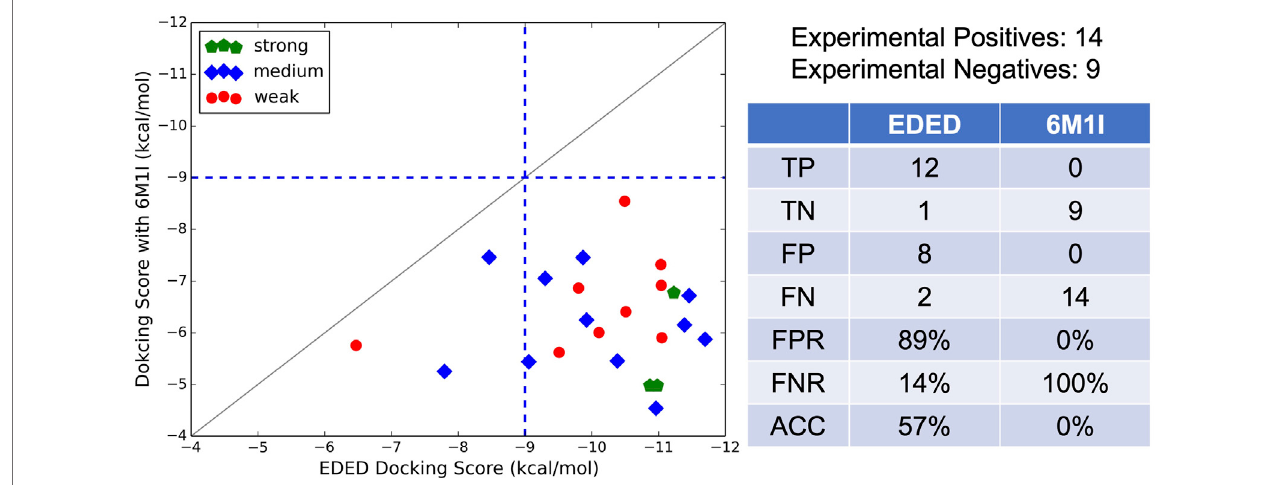
FIGURE 4 | Ensemble weighted glide scores ( Δ G bind ) of 23 experimentally tested compounds. Compounds with strong, modest, and poor ERK inhibitive activity are depicted in green, blue, and red, respectively. Corresponding colored lines represent the average ensemble weighted glide score for that category. A cutoff of – 9 kcal/mol was applied for predicted antagonists to be compared to their experimental results showing either strong or medium inhibition (active) or weak inhibition (inactive).